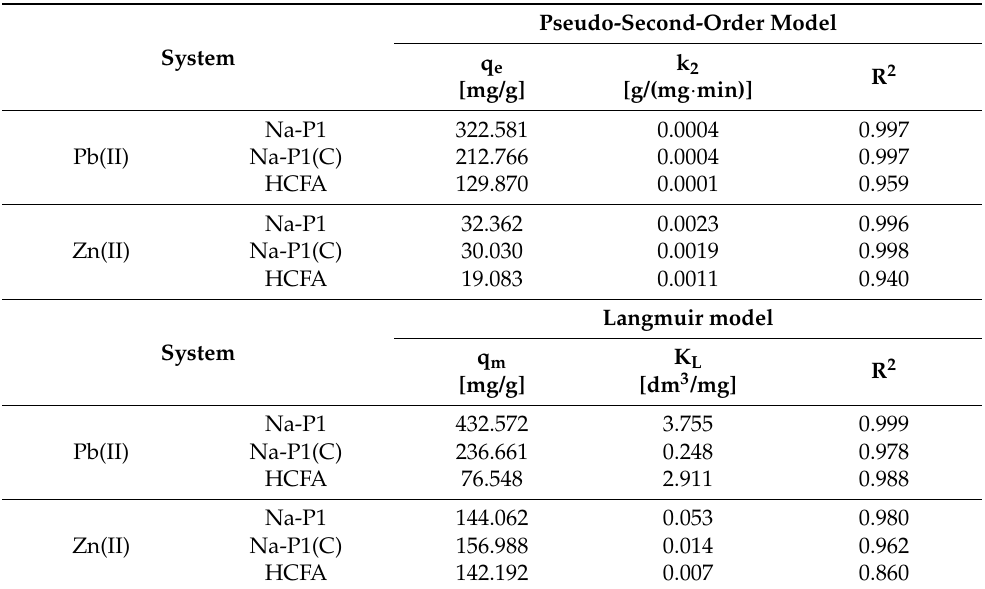
Figure 8. Adsorption kinetics isotherms of Pb(II) ( a , c ) and Zn(II) ions ( b , d ) on the HiC FA, Na-P1 and Na-P1(C) surfaces in the single systems at pH 5. Table 4. Kinetics and isotherm parameters of Pb(II) and Zn(II) adsorption on the HiC FA, Na-P1 and Na-P1(C) surfaces at pH